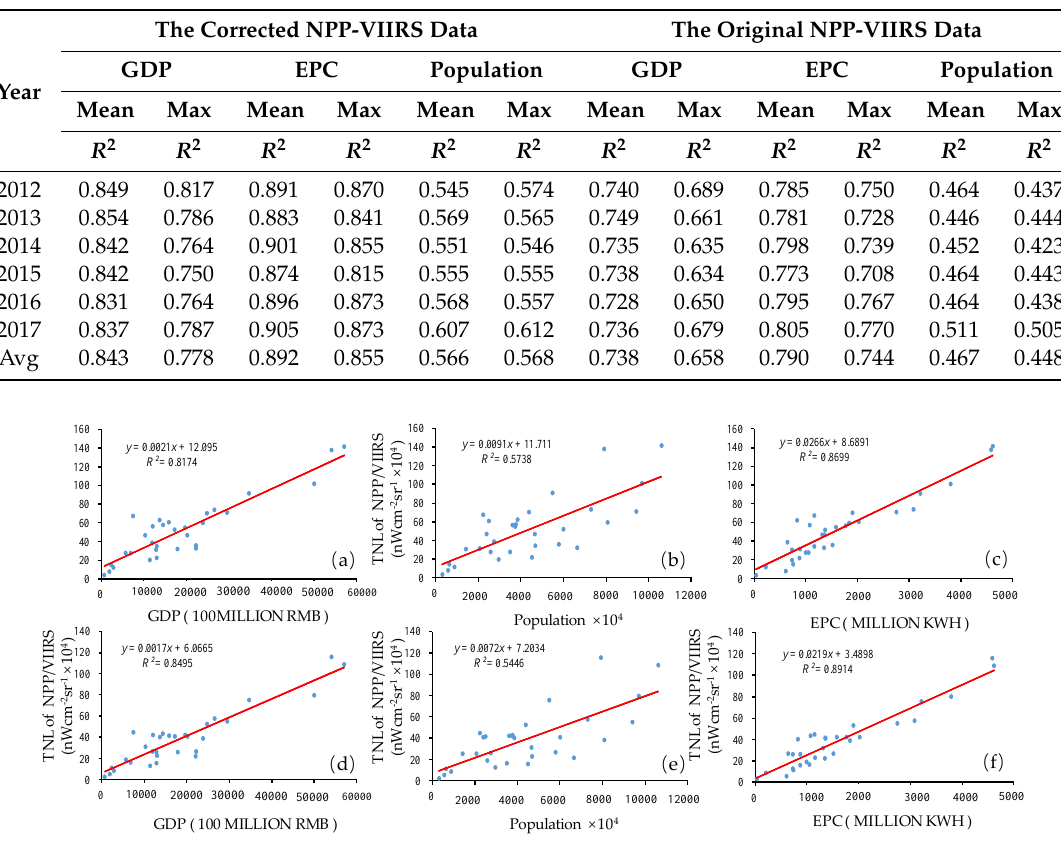
Table 1. Regression results for the corrected and original NPP-VIIRS data. Noted: Mean represented the yearly composite mean data; Max represented the yearly composite maximum data. Avg represented the average results.